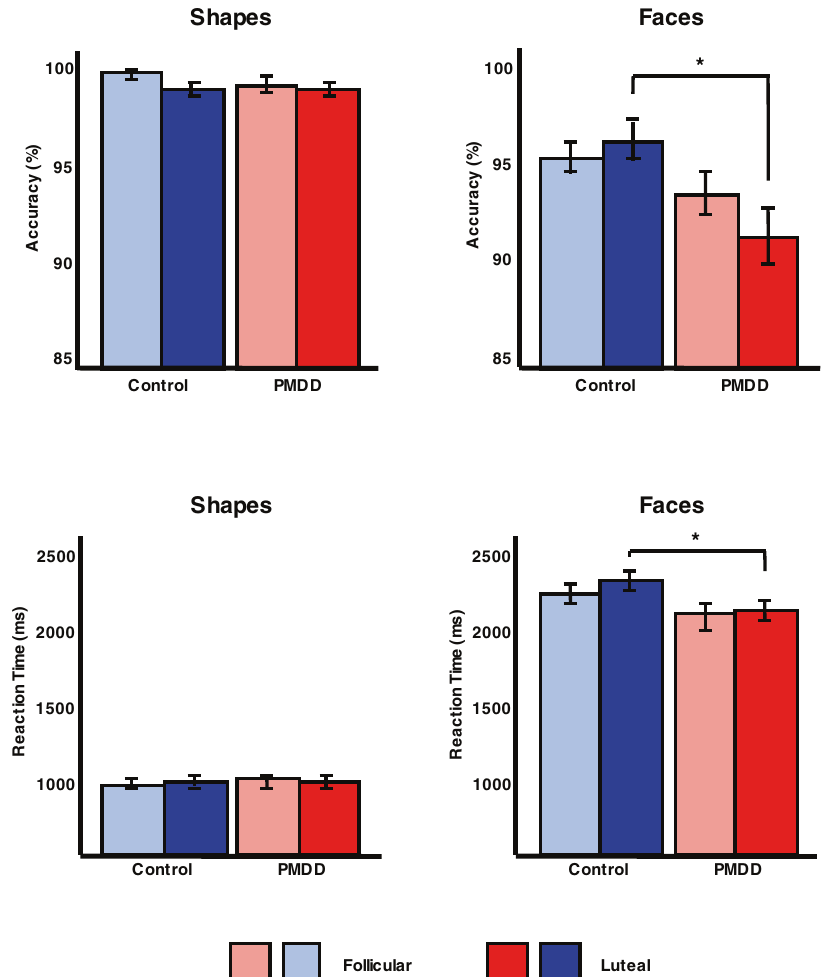
Fig. 1 Emotional task performance in subjects with PMDD ( N = 29) and controls ( N = 27). Subjects with PMDD showed lower accuracy and reaction times in the face-matching condition compared with controls during the late-luteal phase. * p < 0.05. Error bars indicate 1 standard error of the mean. PMDD, premenstrual dysphoric ( p FWE < 0.10, TFCE, small volume corrected) (Figure S2), but not during the mid-follicular phase. No signi fi cant effects of menstrual cycle phase were seen in either group.